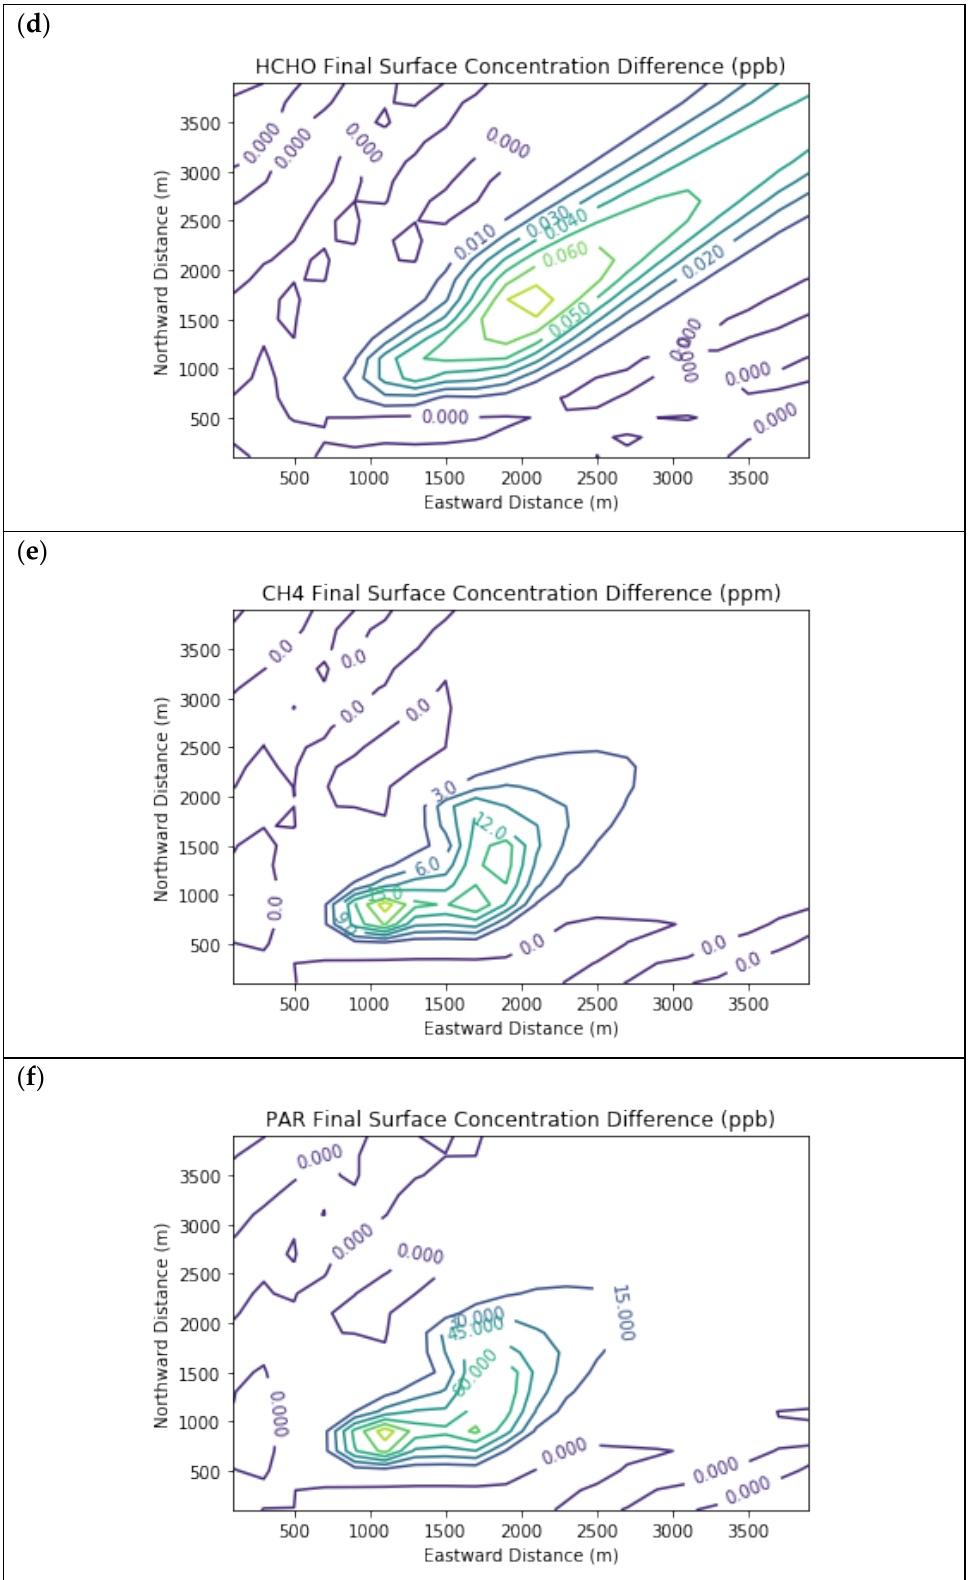
Figure 5. Near Source: Fugitives + Combustion − Combustion Only. Difference plots of ( a ) NO, ( b ) NO 2 , ( c ) O 3 , ( d ) HCHO, ( e ) CH 4 , and ( f ) PAR between the Fugitives + Combustion and Combustion Only scenarios at the end of the 3-h simulation for the 4 km × 4 km domain.